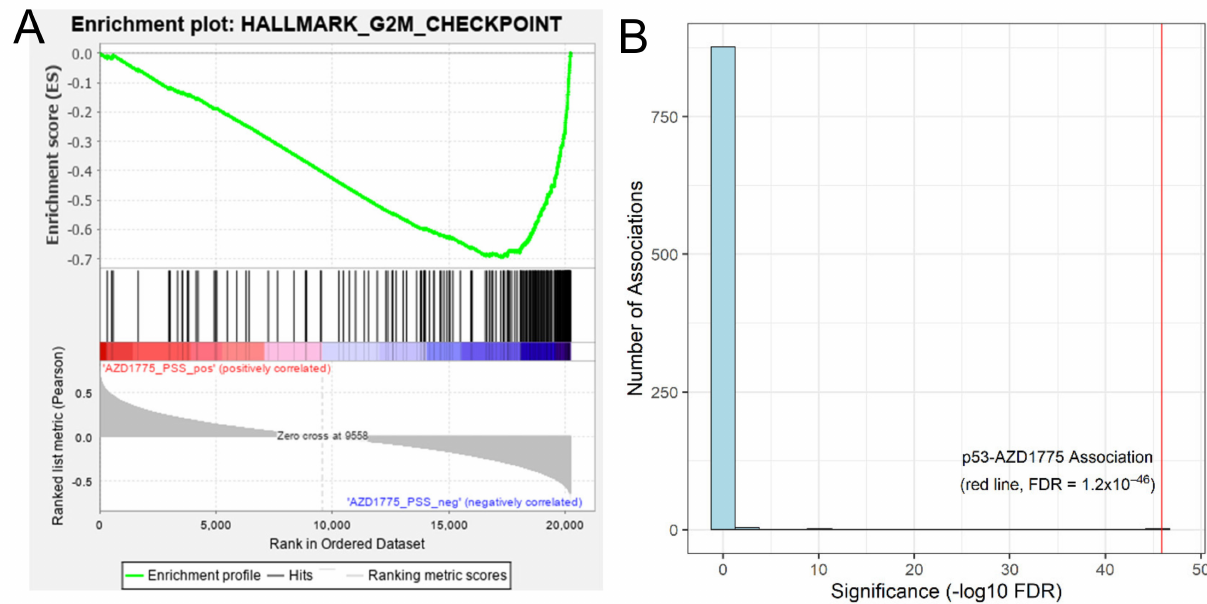
Figure 2. Biologically meaningful associations with AZD-1775 imputed sensitivity in TCGA breast cancers. ( A ) Gene set enrichment analysis was performed in MSigDB’s “Hallmark” gene sets using TCGA’s breast cancer expression data with AZD-1775 imputed sensitivity score as the continuous phenotype variable for enrichment. The G2M gene set was significantly up-regulated in breast cancer patients predicted to be sensitive to AZD-1775 with an enrichment score of − 0.695, normalized enrichment score of − 1.86 and an FDR q-value of 0.04 (associated data in Table S4). A negative enrichment score associates with sensitivity to the drug as smaller imputed sensitivity values indicate more sensitive ( B ) A histogram of p -values achieved for all the associations between AZD-1775 imputed response and any gene with a somatic protein-coding change in at least 20 samples ( n = 882 genes) in TCGA breast cancer cohort. TP53 mutation and AZD-1775 achieves the strongest association at an FDR = 1.2 × 10 − 46 , with the next most significant association at an FDR of 1.2 × 10 − 13